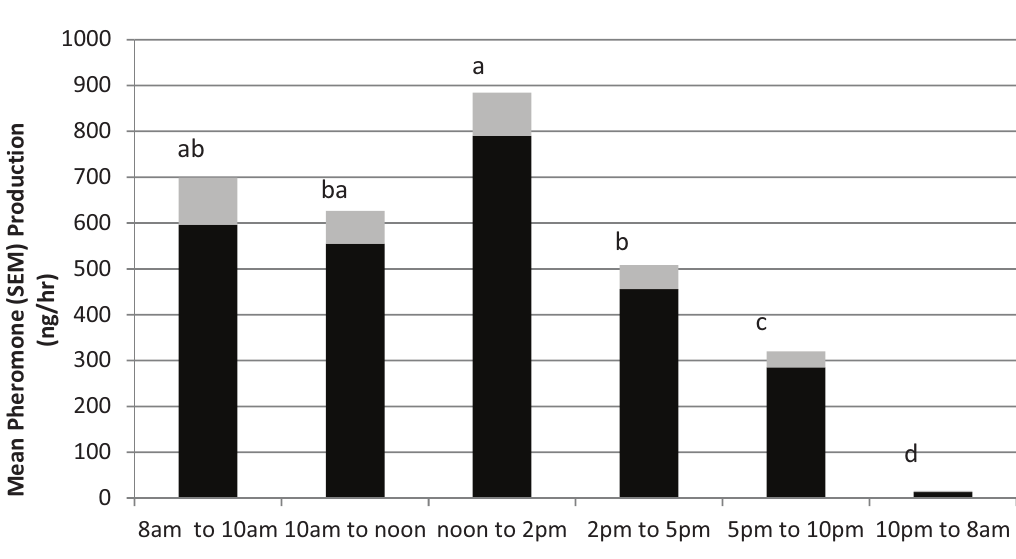
Figure 2. Effect of time of day on male pepper weevil pheromone production. “Lights on” at 8am and “lights off” at 10 pm. Values represent means (solid bars) and standard deviation of the mean (SEM) (gray bar) and are means over 5 days of collections. Means without letters in common differ significantly using LSD ( p =